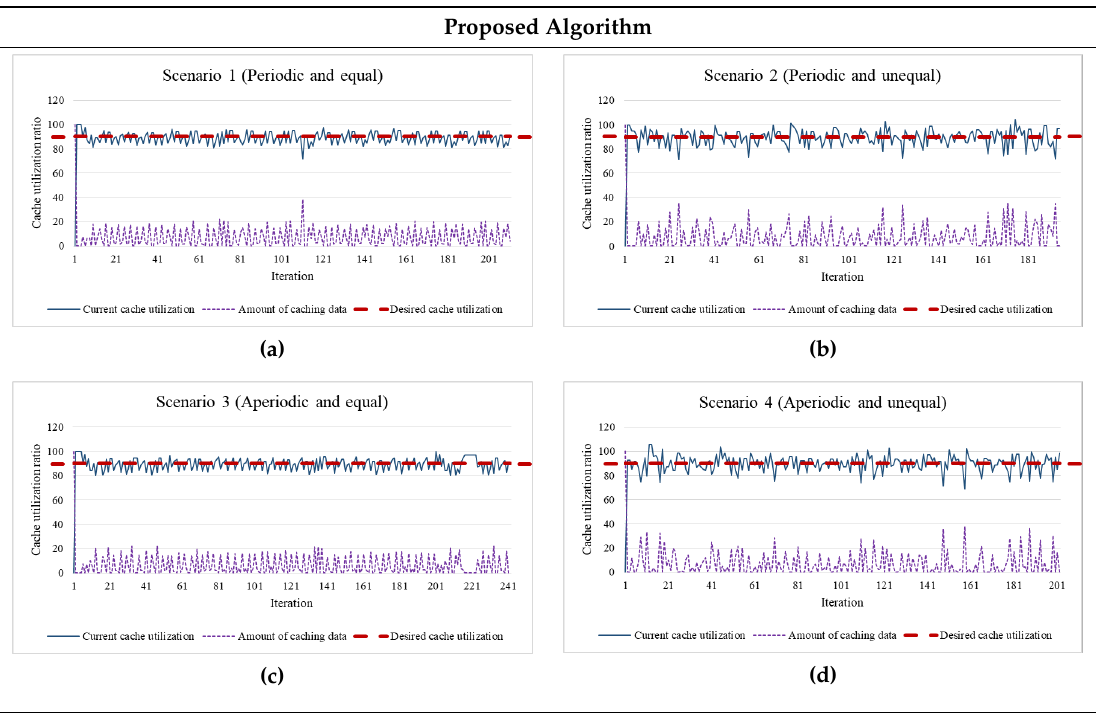
Table 5. Representative performance evaluation results of proposed